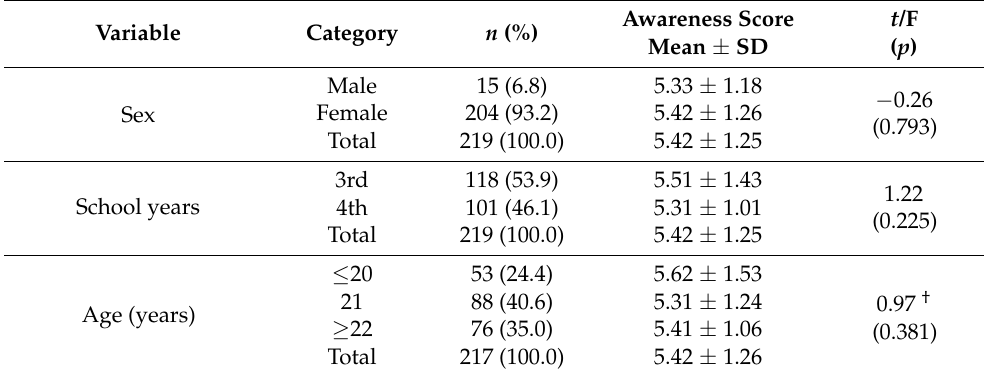
Table 2. Demographic characteristics and anaphylaxis awareness differences among participants (n =